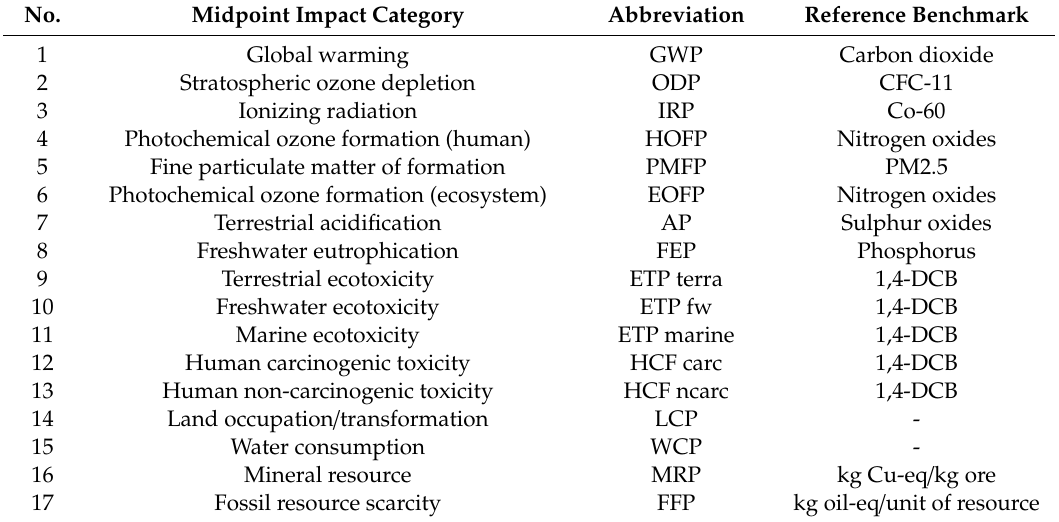
Table 1. Benchmark pollutant emission for 17 midpoint impact categories and